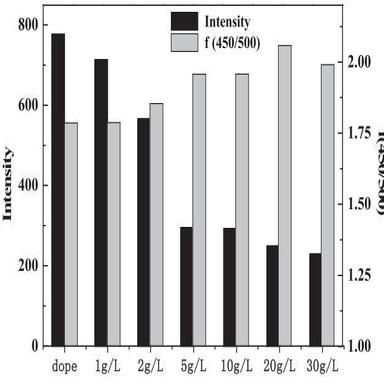
Fluorescence intensity and f (450/500) in leachate treated with different dosage of AC and Ca (OH)2.